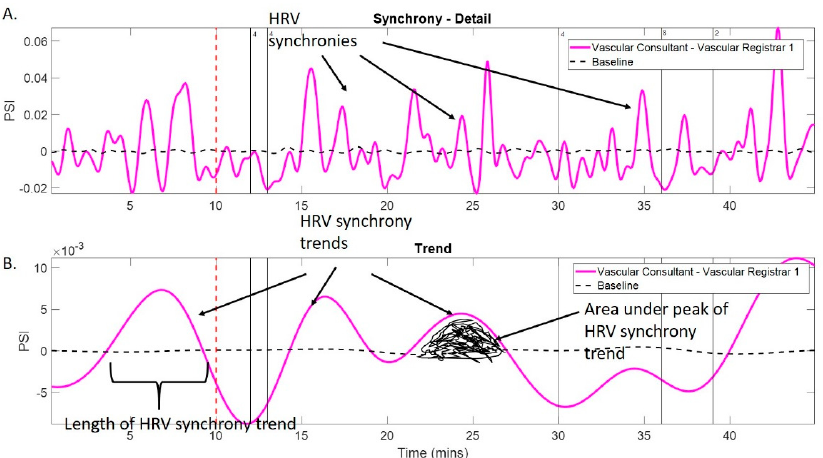
Figure 1. Example of synchrony analysis in a vascular surgical pair. ( A ) shows detailed HRV syn- chrony (magenta) for the duration of the procedure, black arrows show HRV synchronies; ( B ) shows the trend of HRV synchrony for that procedure (magenta), the baseline synchrony is also shown (black, dotted), HRV synchrony trends are marked with black arrows, length of the HRV synchrony trend is marked with a black bracket and area under the peak of the HRV synchrony trend is marked in black.